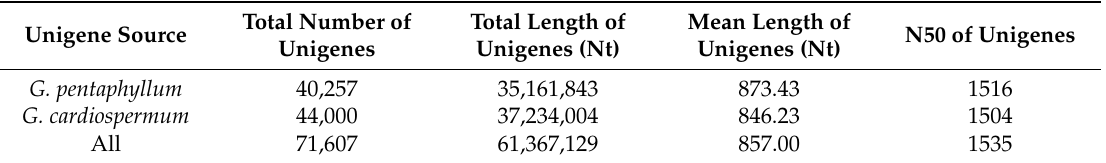
Table 2. Summary of the unigenes from two Gynostemma species.